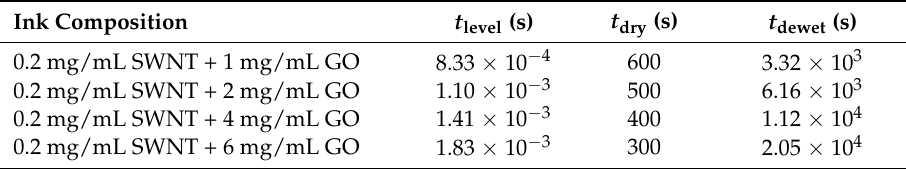
Table 1. Time parameters for fabricating TCs using GO-SWNT